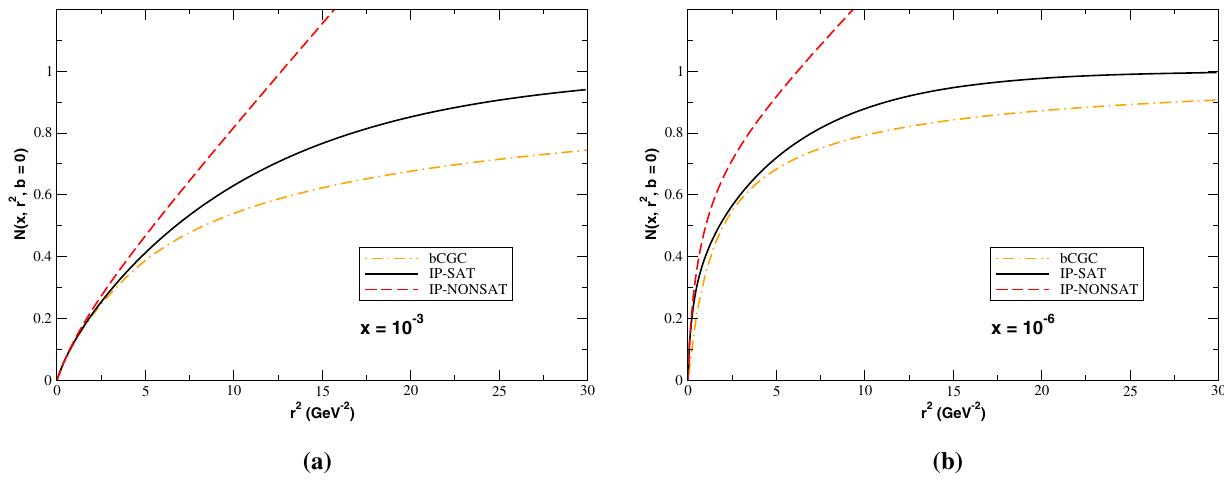
Fig. 3 Dipole-proton scattering amplitude as a function of the squared dipole size for two distinct values of x